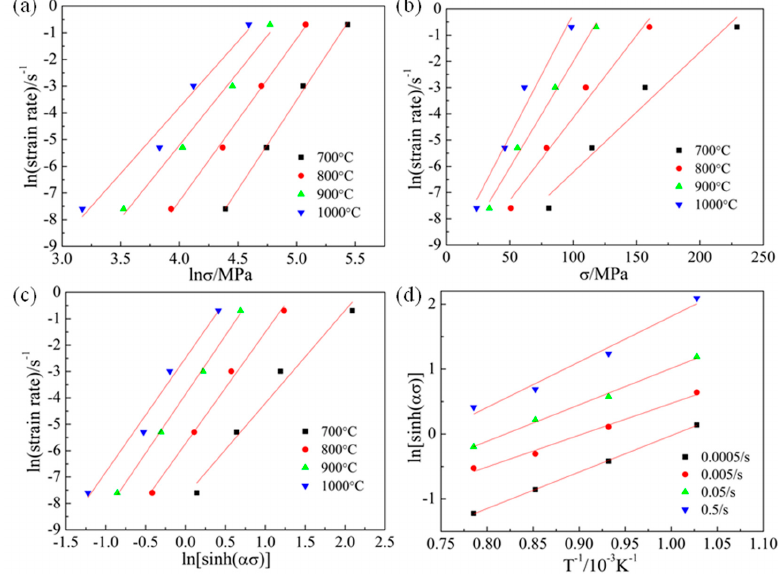
Figure 3. Determination of material constants by means of fitting method based on experimental data: ( a ) Solving the value of n ; ( b ) Solving the value of β ; ( c ) Modifying the value of n ; ( d ) Solving the value of Q .